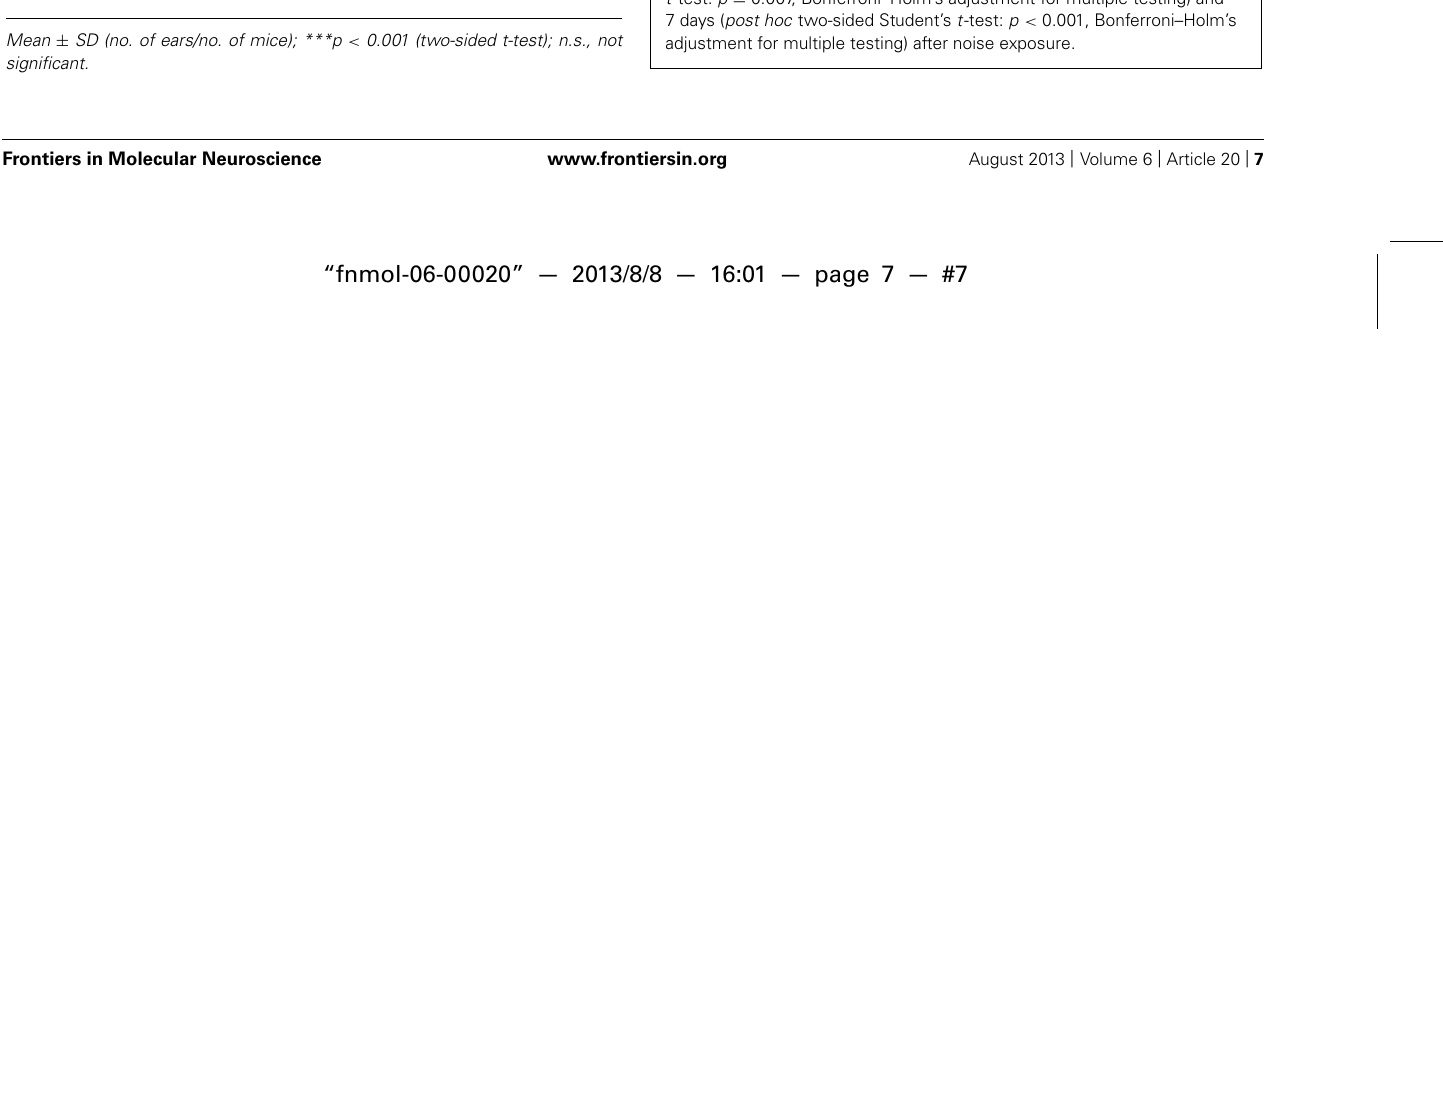
Table 1 |Auditory brainstem response thresholds for Ca V 1.2 Pax2 mouse line evoked by click stimuli. Click-ABR threshold (dB SPL) FIGURE 5 | Preservation of click-ABR thresholds in Ca V 1.2 Pax2 KO mice after noise exposure. Mean ± SD click-ABR threshold losses for control and Ca V 1.2 Pax2 KO mice before noise exposure, after noise exposure at the same day, 1 day, 3 days, and 7 days, showing a significant differences in threshold losses (two-way ANOVA, p < 0.001) between control (14–16 ears, 7–8 mice) and KO (16 ears, 8 mice). Significant differences in threshold loss were observed at 3 days ( post hoc two-sided Student’s t -test: p = 0.007, Bonferroni–Holm’s adjustment for multiple testing) and 7 days ( post hoc two-sided Student’s t -test: p < 0.001, Bonferroni–Holm’s adjustment for multiple testing) after noise